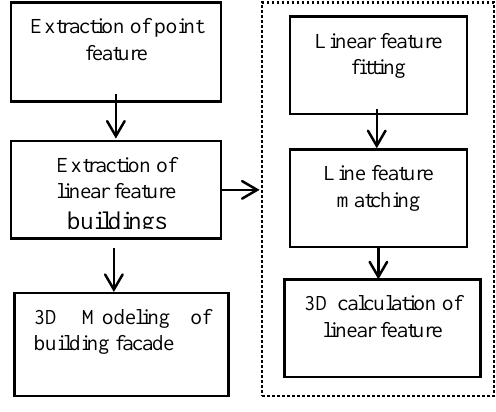
Fig.1 The Process of Building Facade